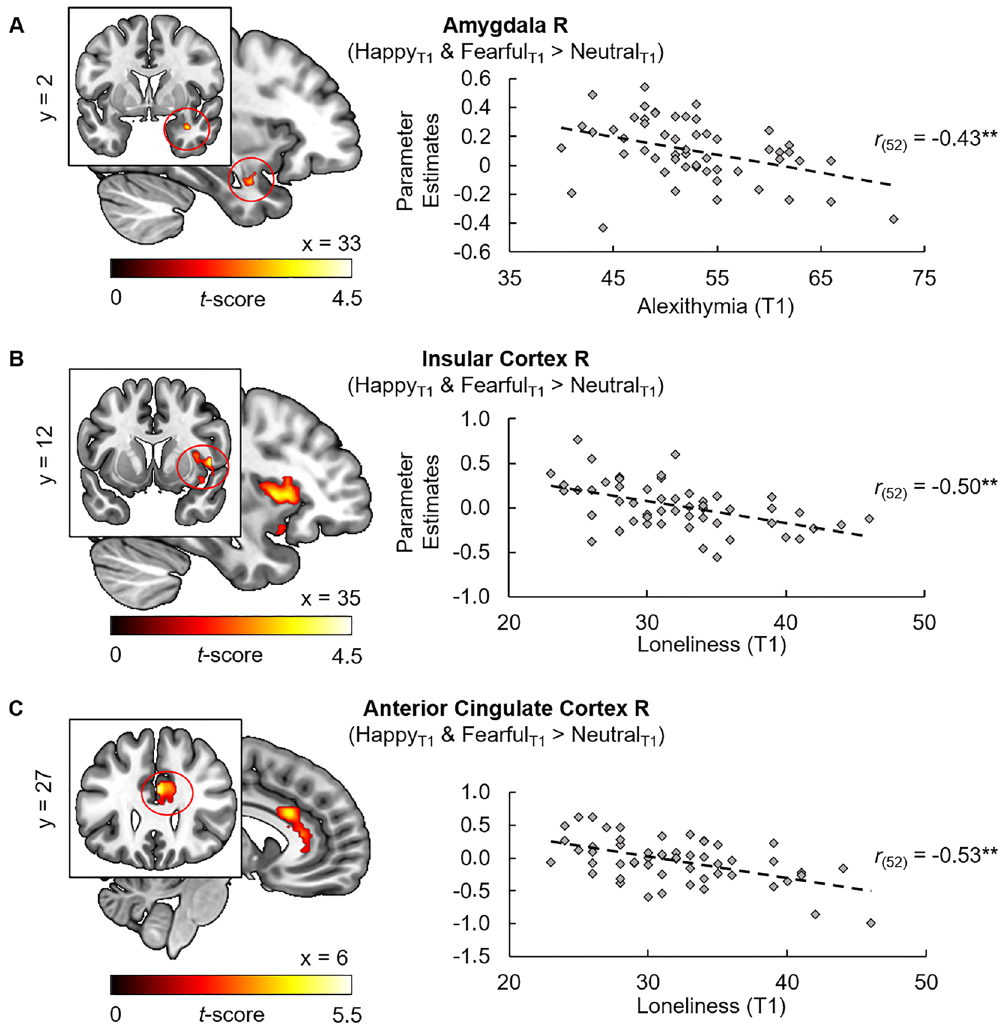
Figure 2. Participants with high alexithymia showed reduced activation to emotional faces compared to neural faces in the right amygdala ( A ; MNI xyz : 34, 2, − 24, t (53) = 3.55, p FWE = 0.03). Individuals with high loneliness exhibited lower responses to emotional faces in the right anterior insular cortex ( B ; MNI xyz : 48, 8, 4, t (53) = 4.21, p FWE = 0.03) and the right anterior cingulate cortex ( C ; MNI xyz : 2, 26, 24, t (53) = 4.82, p FWE < 0.01). For illustration purpose clusters are shown with significance level of p = 0.05. ** p < 0.01, FWE familywise error corrected, L left, MNI Montreal Neurological Institute, R right, T1 study